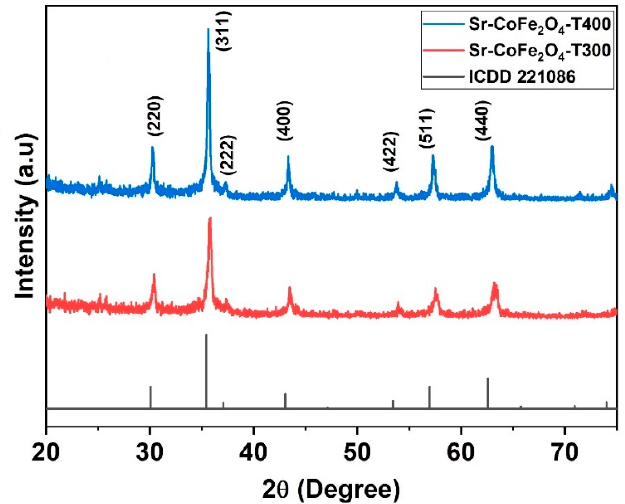
Figure 2. XRD pattern of nanoparticles Sr-CoFe 2 O 4 with difference calcination temperature. Table 2. Crystallite size, lattice parameter and density of nanoparticles Sr-CoFe 2 O 4 at difference cal- cination temperature.